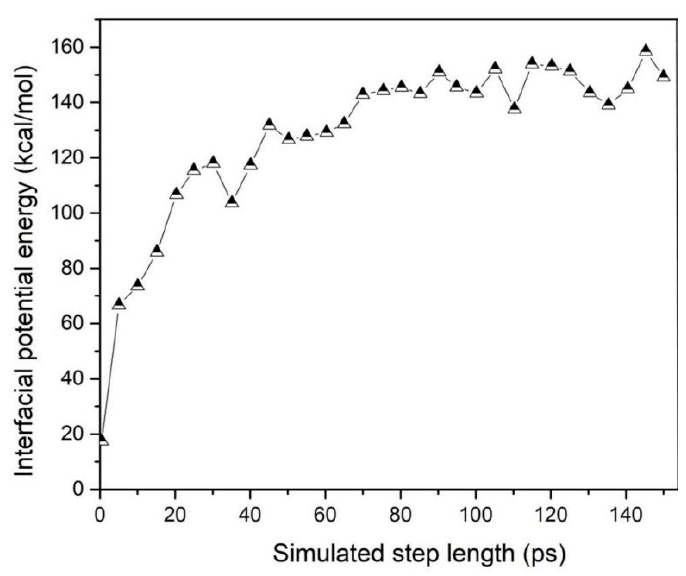
Figure 11. Graph of potential energy of GNS-NR interaction with simulation time.